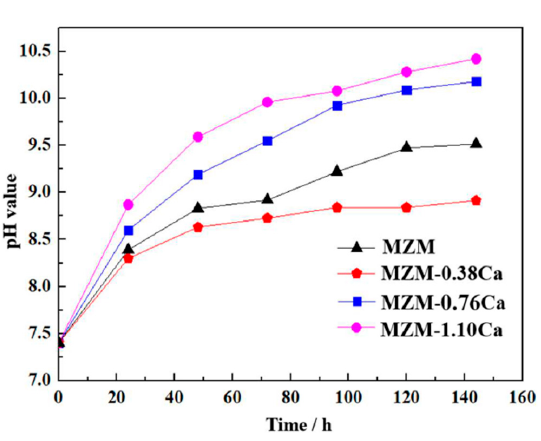
Figure 10. pH value of the studied alloys during the immersion test in Kokubo solution.